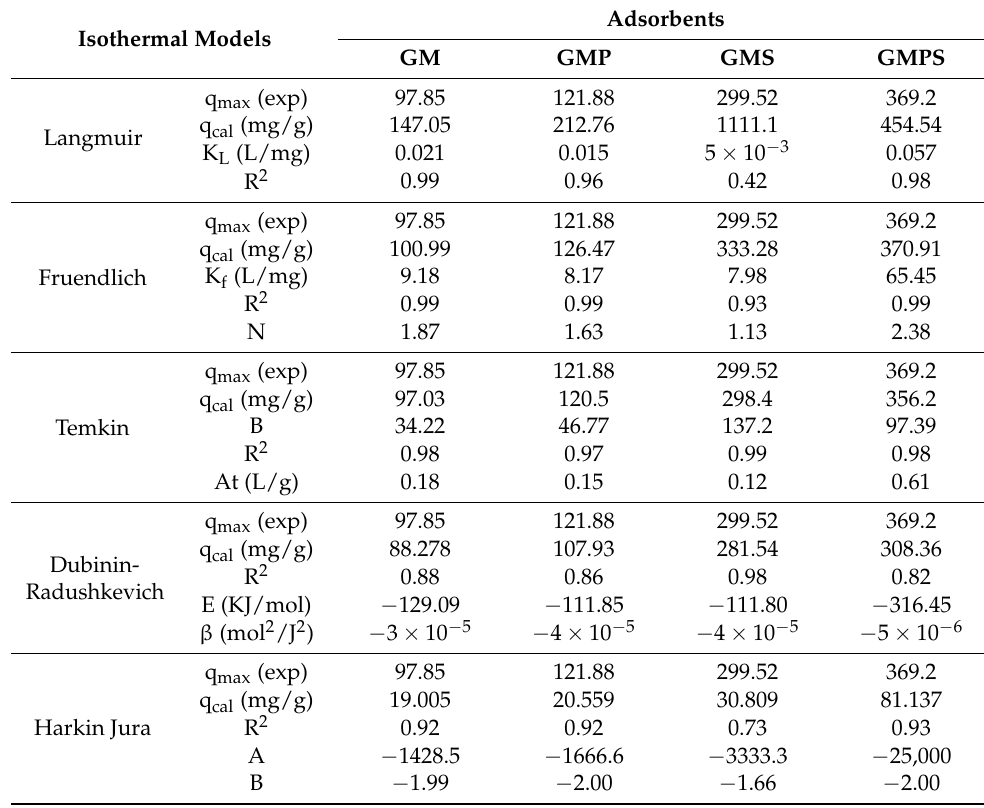
Table 2. Comparison of Langmuir, Fruendlich, Temkin, Dubinin-Radushkevich, and Harkin Jura isotherms for Foron blue